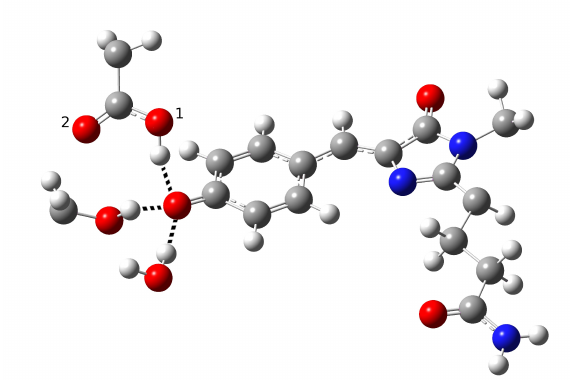
Figure 5. Anionic form resulting from the optimization of psamFP488 starting from the first HB network. This result suggests that this configuration is probably poorly representative of the stable neutral chromophore form in the ground electronic state and its hydrogen bond network. Table 1 shows the main structural parameters extracted from the optimized anionic structure. In particular, the intermolecular oxygen distances of the residues involved in the hydrogen bond network, inter- and intramolecular O-H distances, chromophore C-O distance, and hydrogen bond angles are